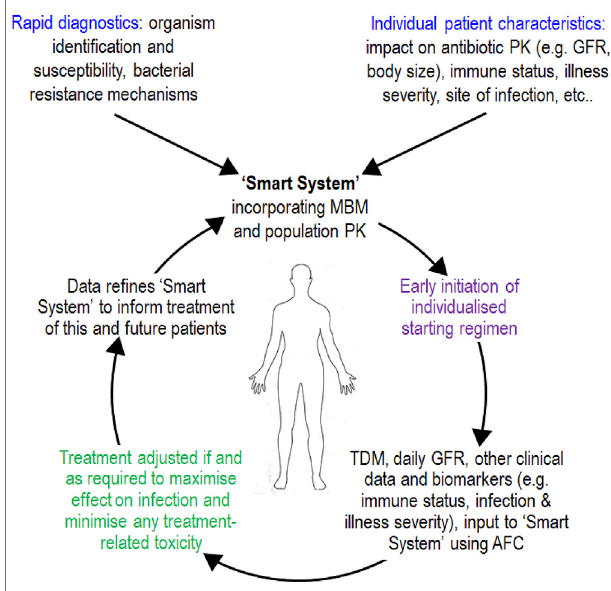
FIGURE 4 | Schematic of model-informed precision dosing (MIPD) achieved via a so-called “ Smart System ” (Landersdorfer and Nation, 2021). Such a system may inform delivery of future precision antibiotic therapy and improve treatment of infections, especially in critically ill patients with sepsis or septic shock who have unstable pathophysiology and dif fi cult-to- treat infections. AFC, adaptive feedback control; GFR, glomerular fi ltration rate; MBM, mechanism-based model; PK, pharmacokinetic; TDM, therapeutic drug monitoring (antibiotic concentration in plasma or, if possible, at the site of infection). The fi gure is a modi fi ed form of Figure 3 in the original publication of Landersdorfer and Nation, 2021.